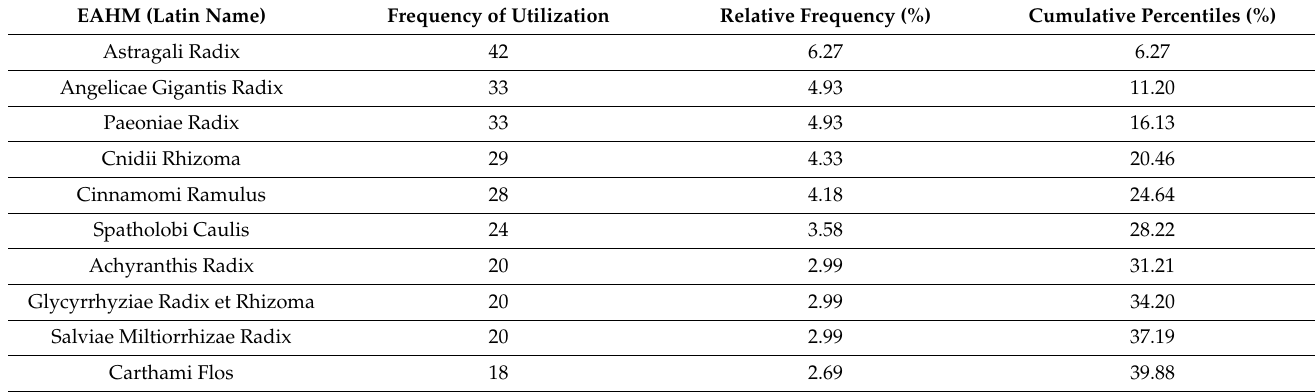
Table 4. The top 10 frequent herbs prescribed for peripheral